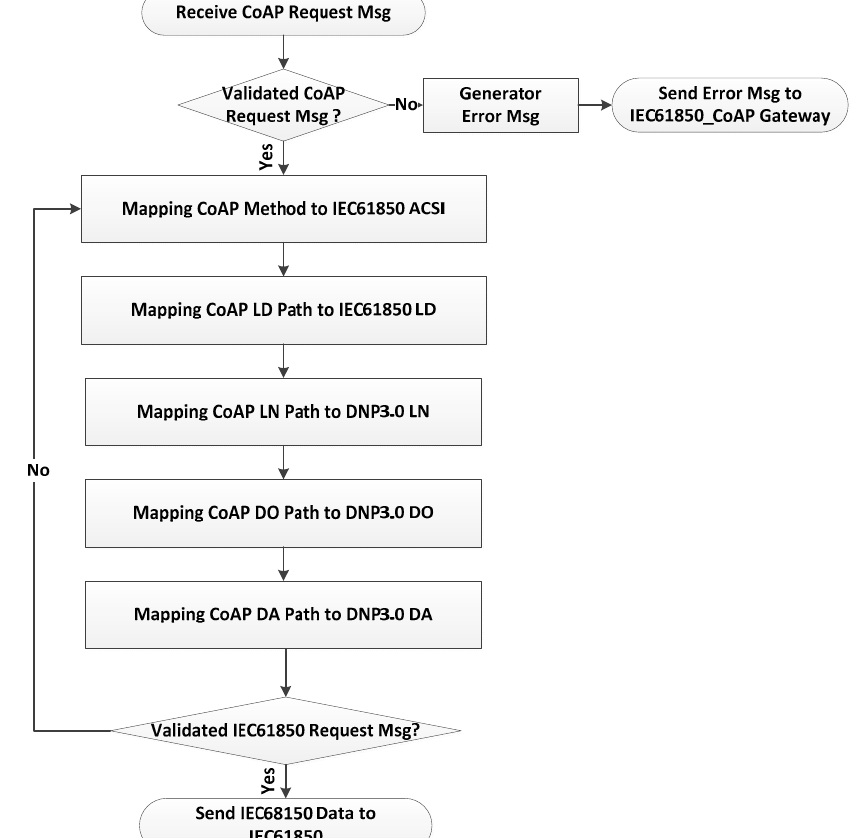
Figure 7. CoAP-to-IEC 61850 mapping process within a CoAP cross-mapping layer.